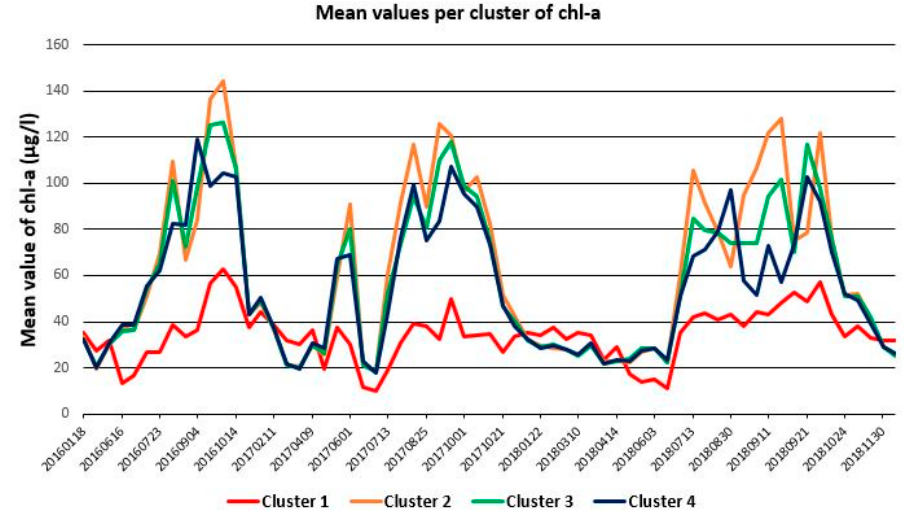
Figure 11. The temporal variation of the chl- a mean values for each cluster.